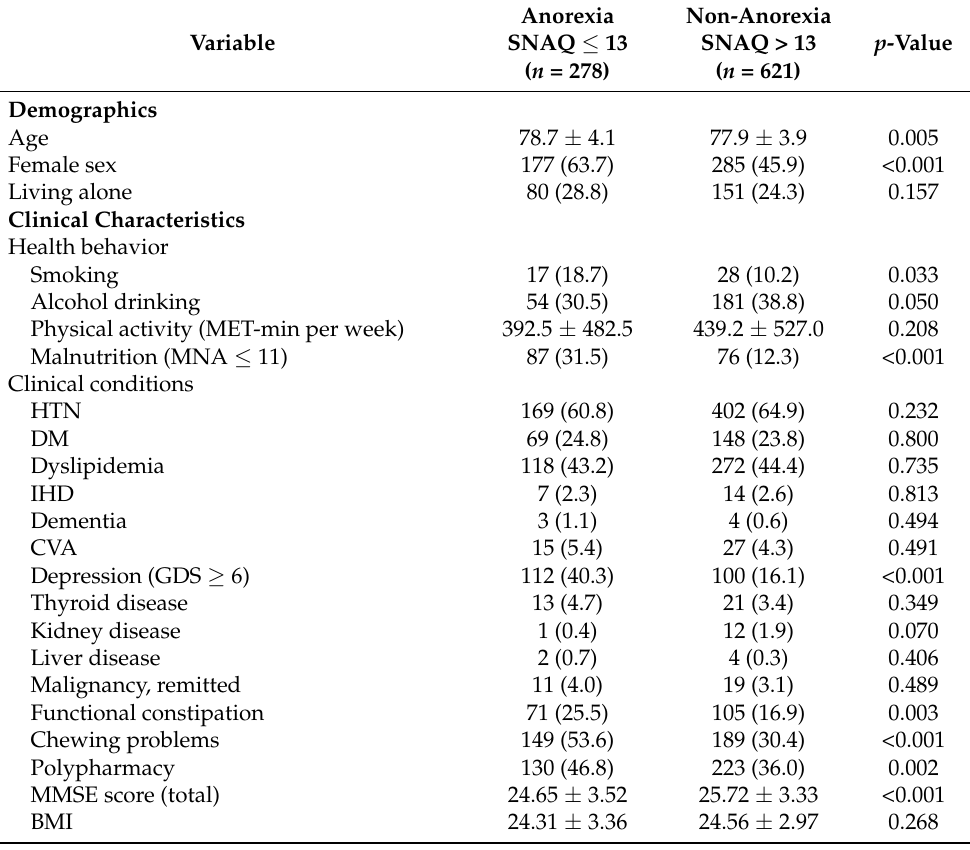
Table 1. General characteristics of community-dwelling older adults according to anorexia.